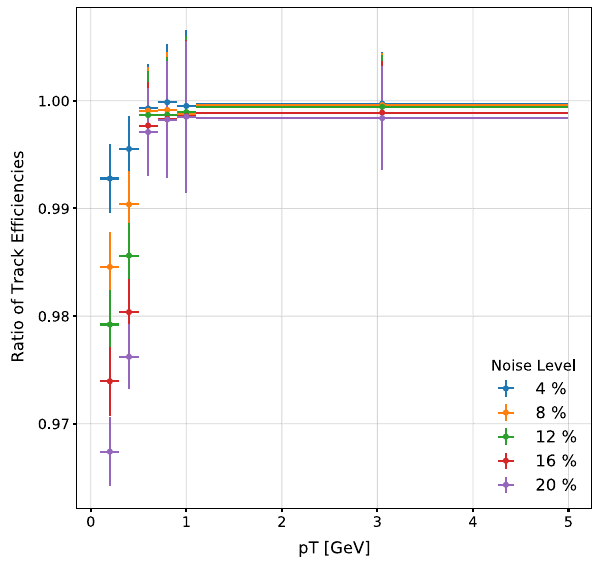
Fig. 7 Relative technical efficiency as a function of p T . Each curve shows the ratio of eff ( noise = N % )/ eff ( noise = 0